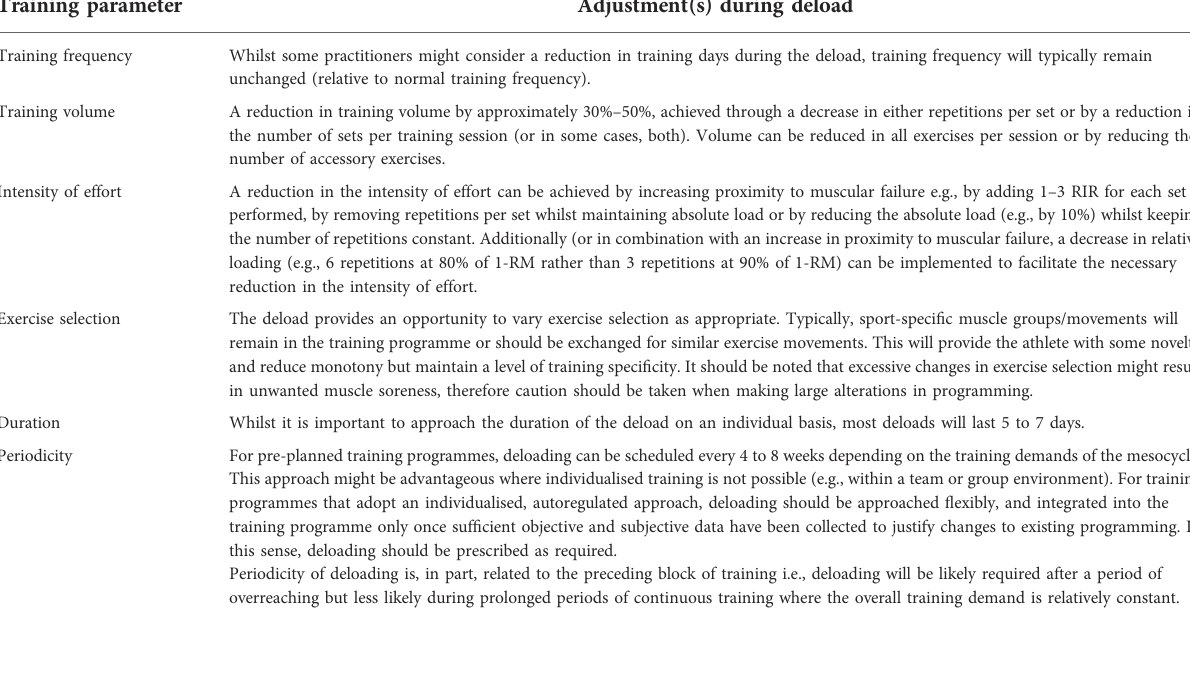
TABLE 3 General guidelines for the prescription of deloading in strength and physique